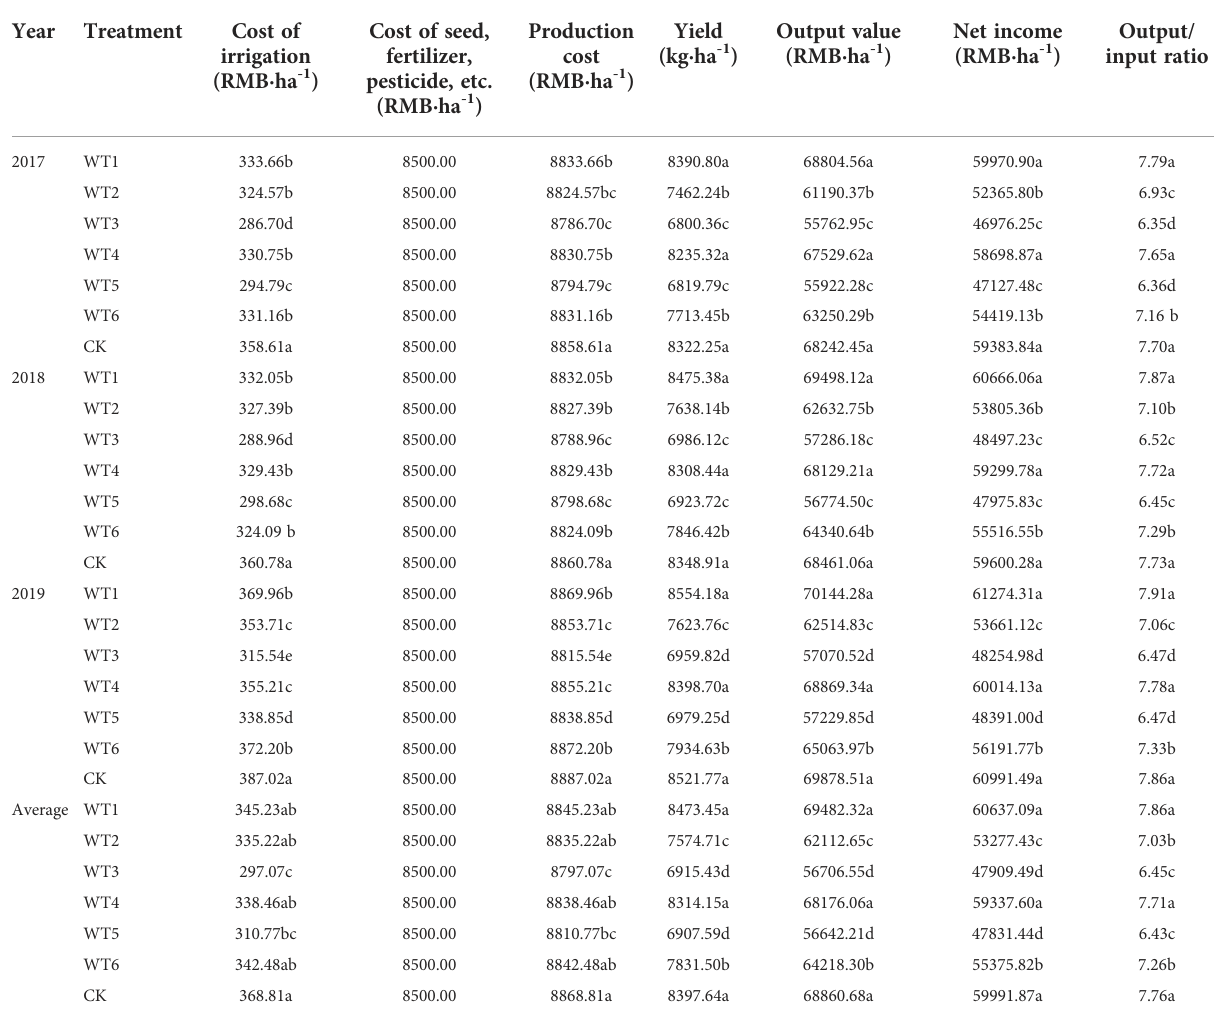
TABLE 3 Economic bene fi ts of I. indigotica in different water de fi cit treatments. Year